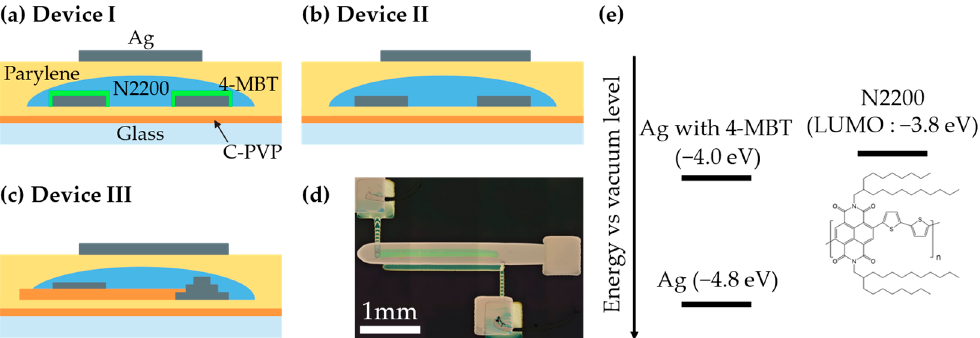
Figure 1. Device structures of ( a ) Device I, ( b ) Device II and ( c ) Device III. ( d ) Optical microscope image of the Device III. ( e ) Molecular structure and energy diagram of N2200 and silver electrodes.